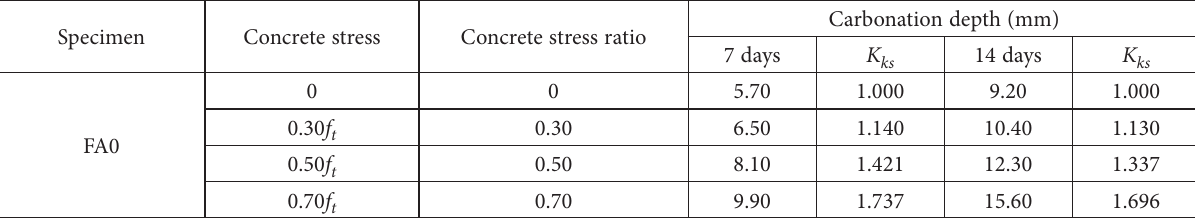
Table 10. Carbonation depths of specimens under different concrete stress conditions (data from Wang et al., 2017)